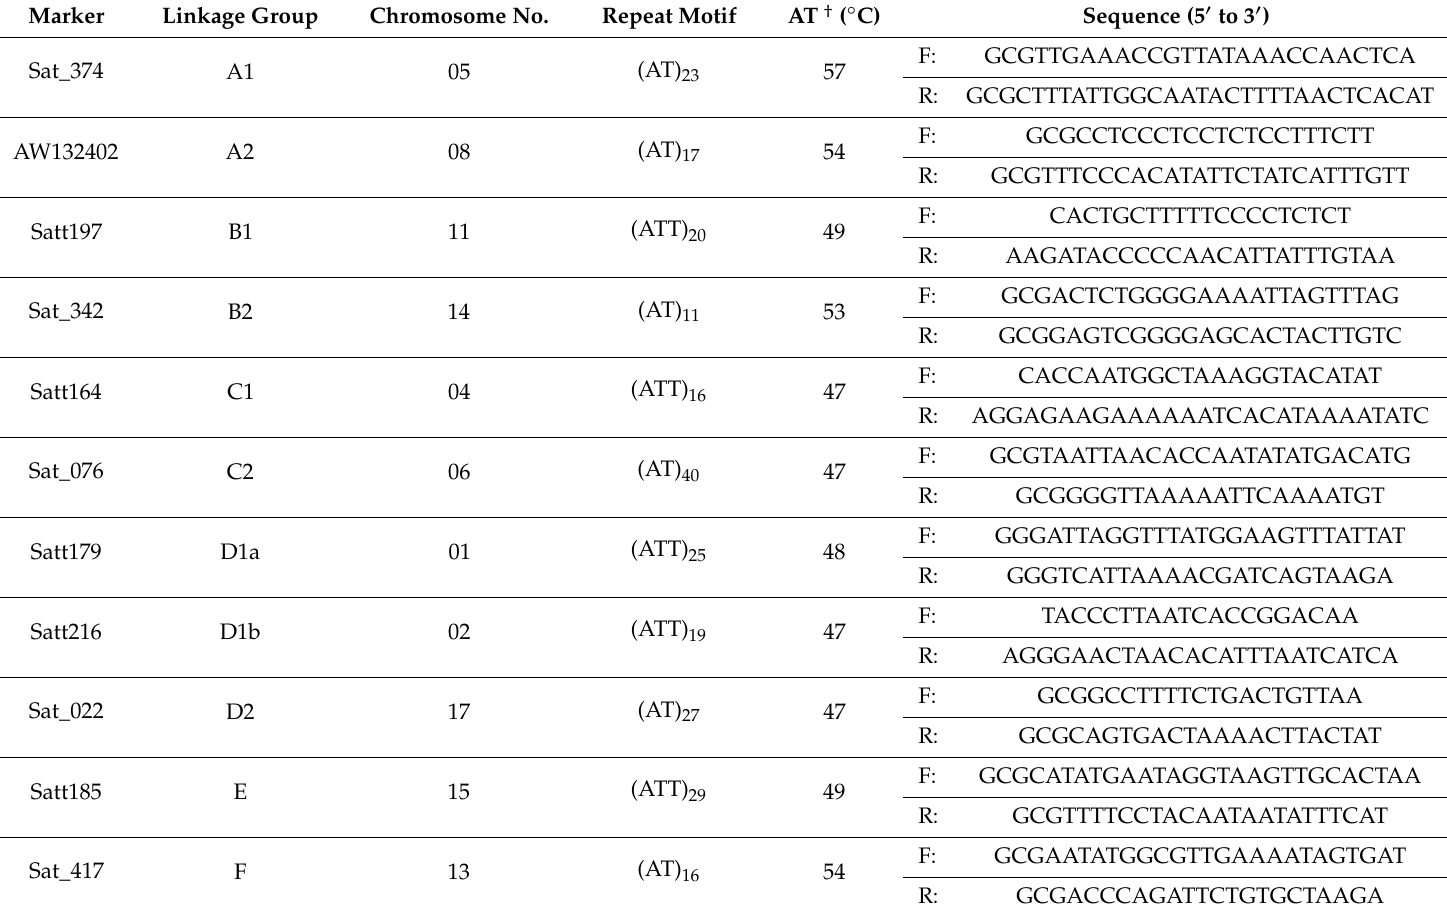
Table 2. Information of the 20 markers used for simple sequence repeat (SSR) analysis in this